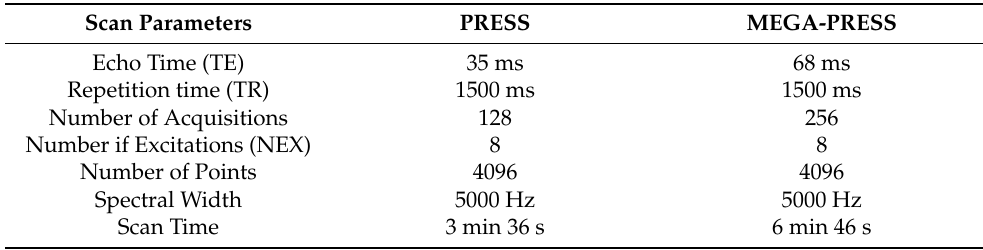
Table 1. PRESS and MEGA-PRESS sequence parameters. For MEGA-PRESS, there were 128 acquisi- tions with editON and 128 acquisitions with editOFF. Both sequences had 16 water unsuppressed acquisitions at the very beginning as is standard for PRESS on a GE scanner.